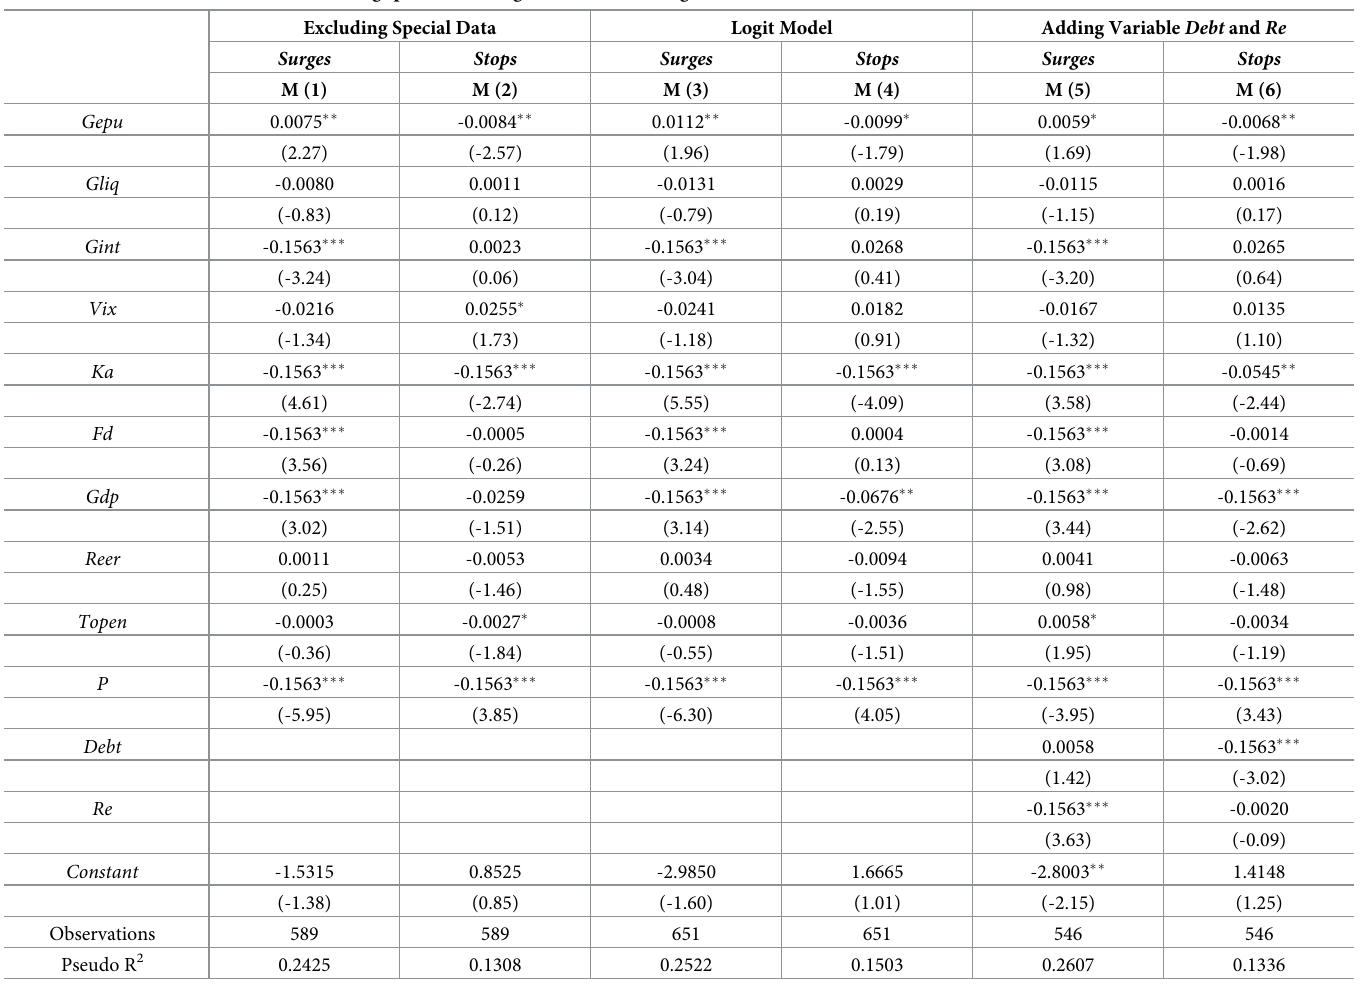
Table 10. Robustness test results of excluding special data, Logit model and adding two